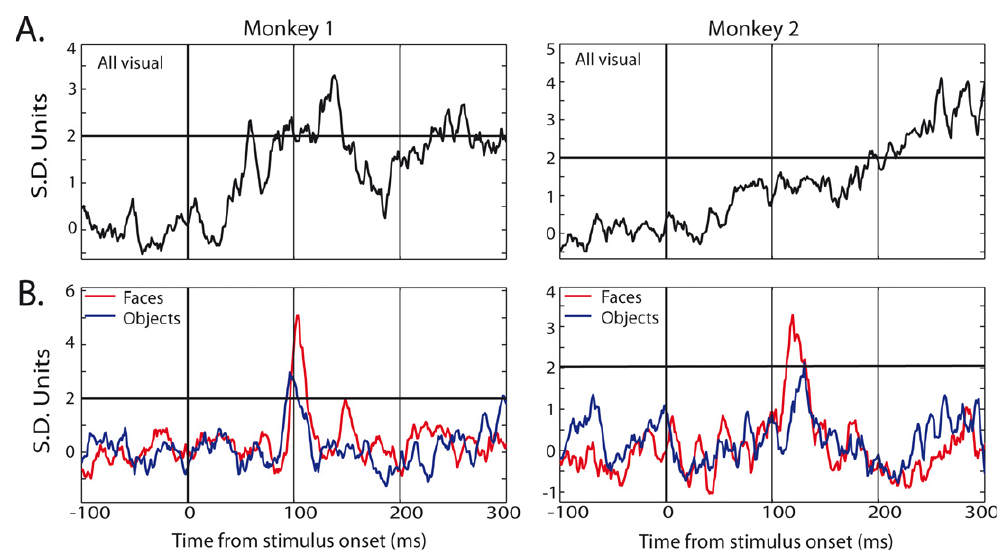
Figure 3. Example MUA responses in auditory cortex from four electrode sites. (A) Mean response to visual stimuli, collapsed across category, for elec- trode sites in monkey 1 (left) and monkey 2 (right). (B) Mean responses to face (red) and object (blue) stimuli, for electrode sites in monkey 1 (left) and monkey 2 (right). Responses are shown in standard deviation units from baseline activity (the horizontal line indicates 2 SD units), aligned to stimulus